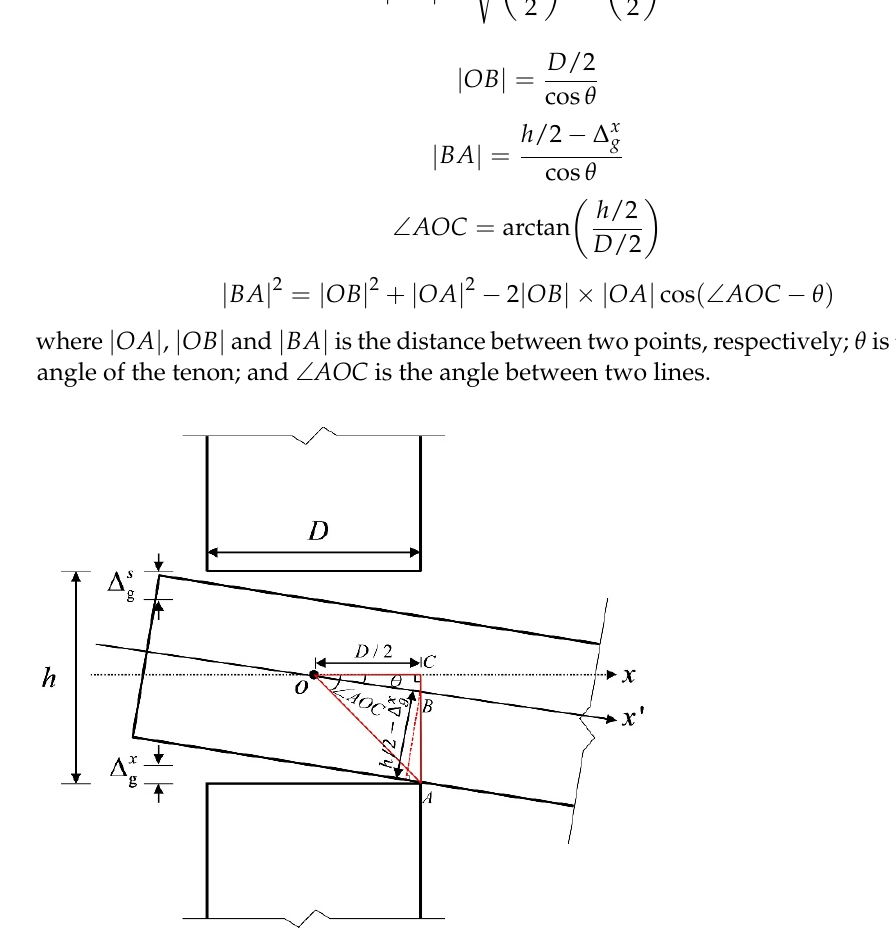
Figure 7. Free rotation.